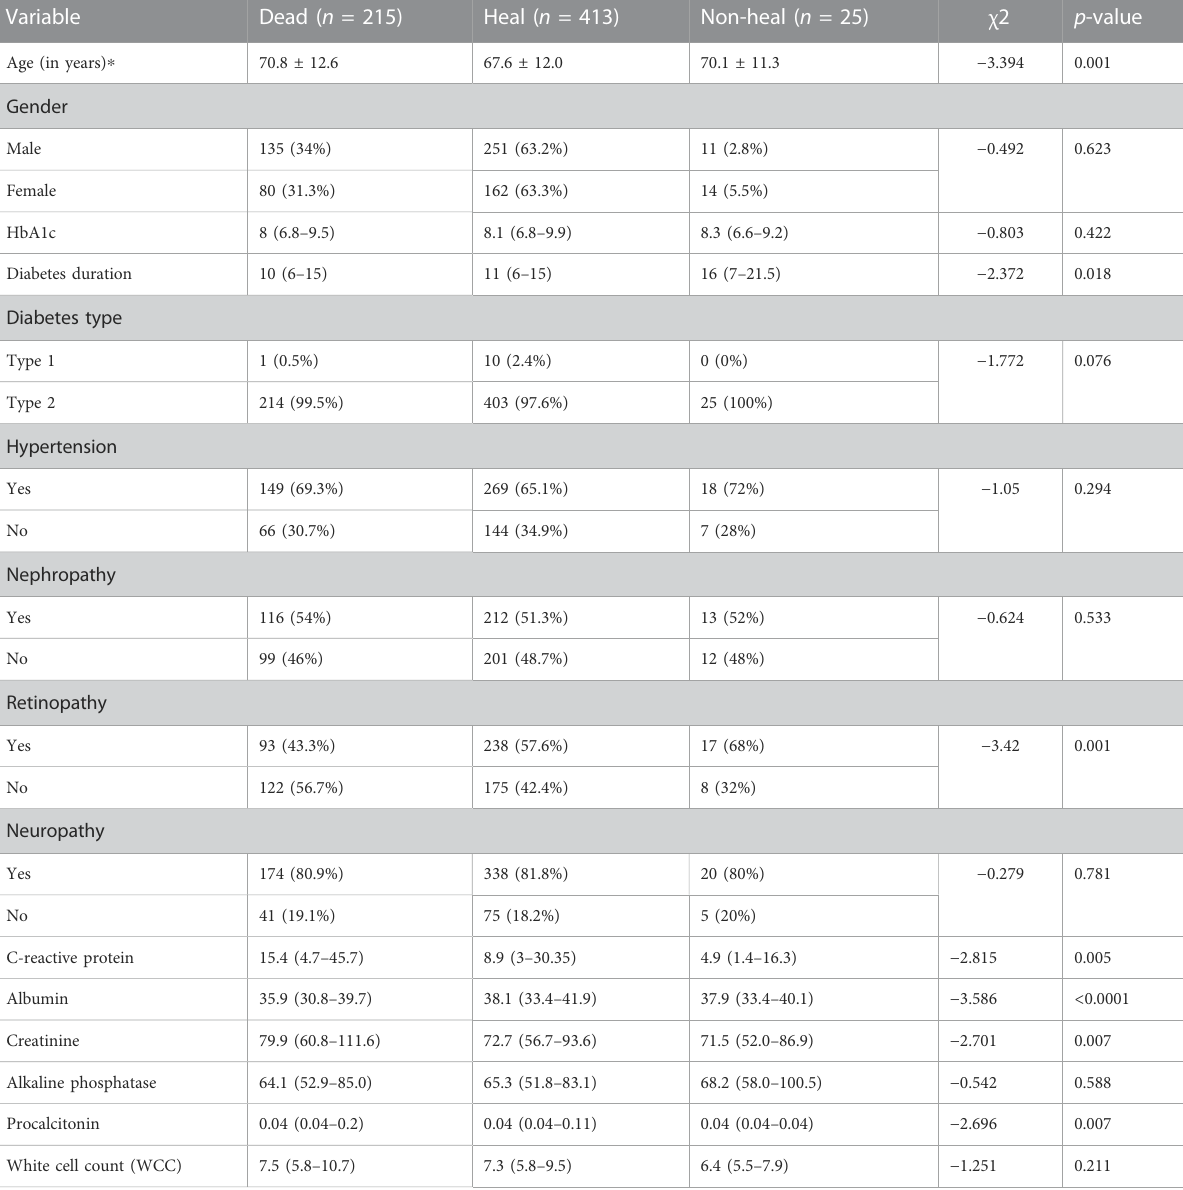
TABLE 3 Comparison of risk factors for DFU mortality. * p < 0.05, ** p < 0.01, and *** p < 0.001.